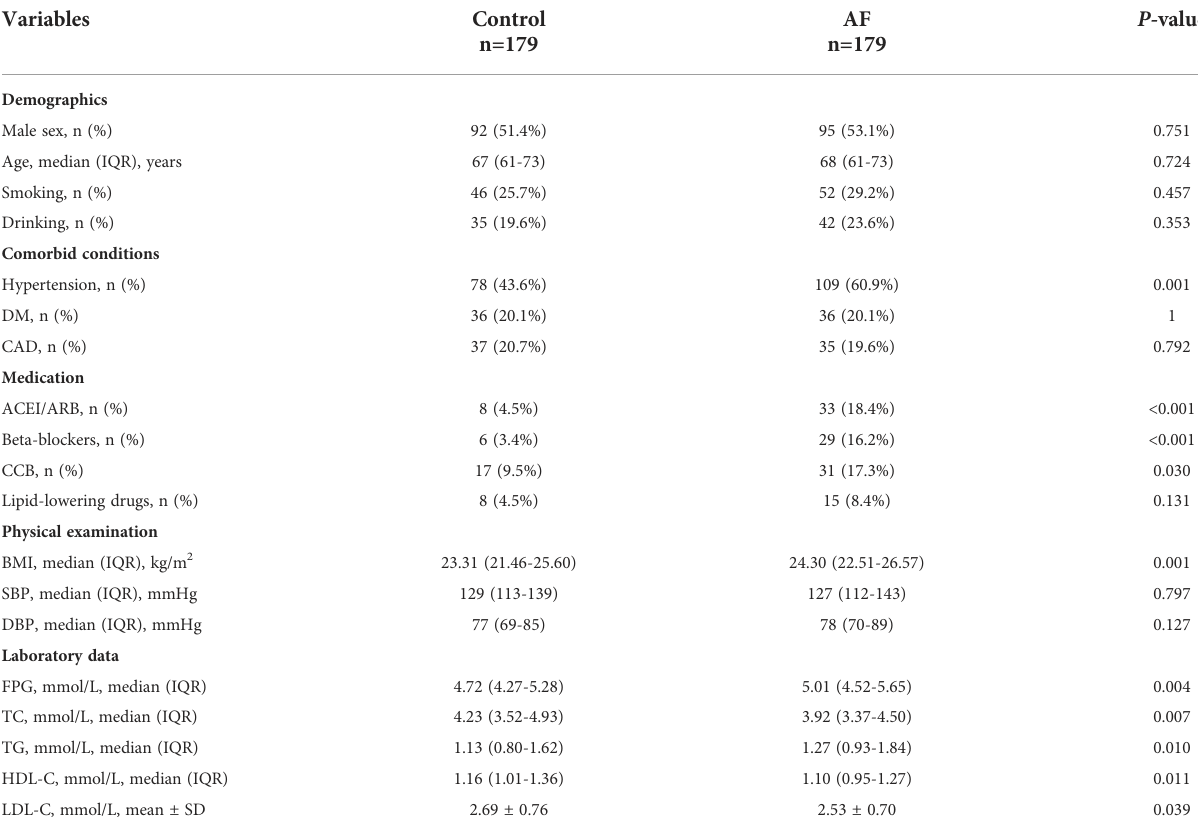
TABLE 1 Baseline characteristics of all